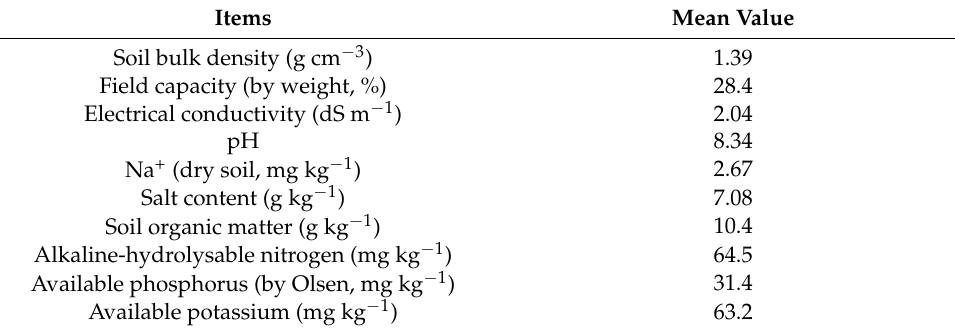
Table 1. Soil properties of the top 0.30 m layer prior to experiments.